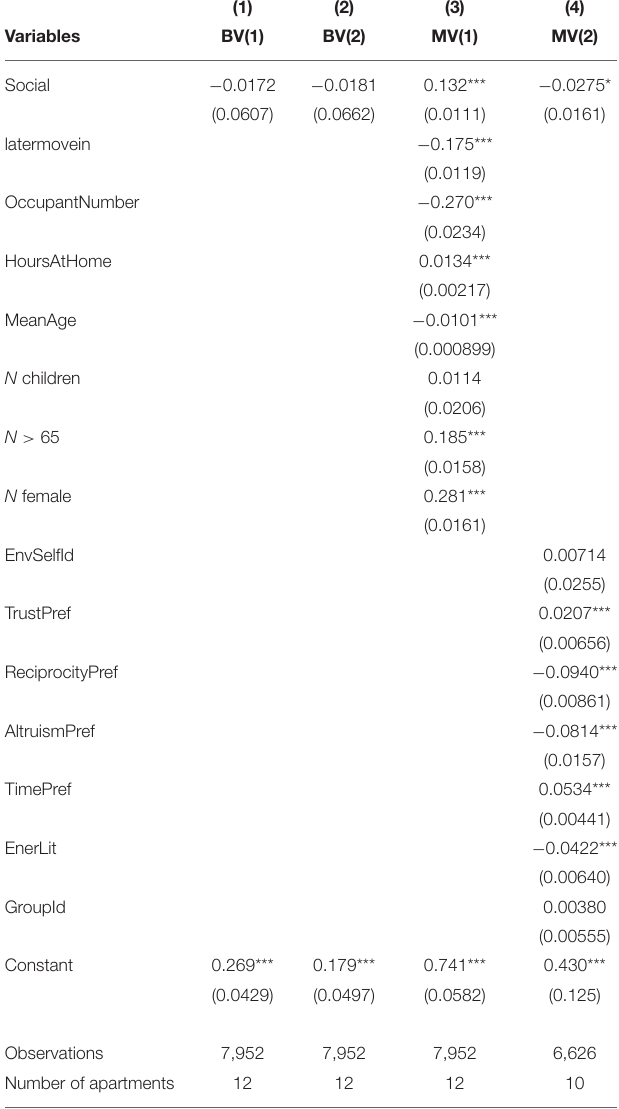
TABLE 5 | Results from GLS random effects regression including only